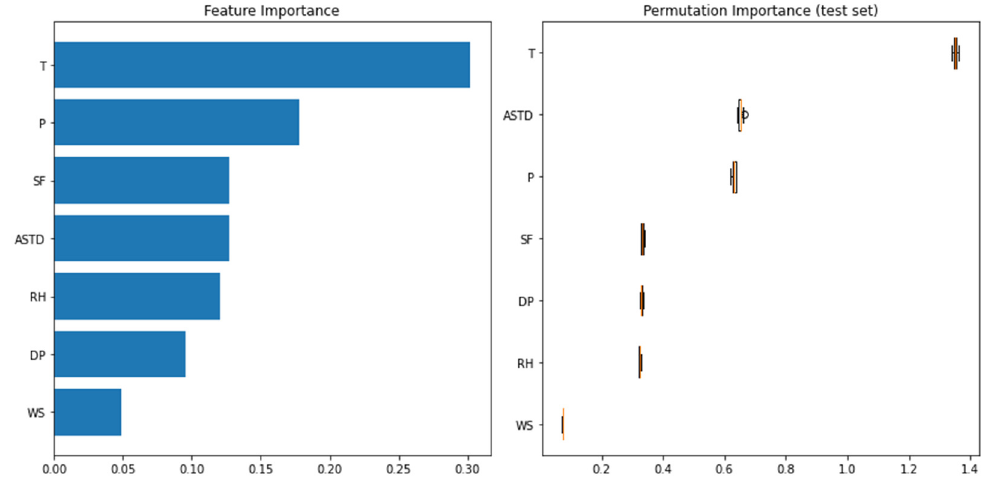
Figure 10. Feature importance ( left ) and permutation importance ( right ) for the GBR model estimators.